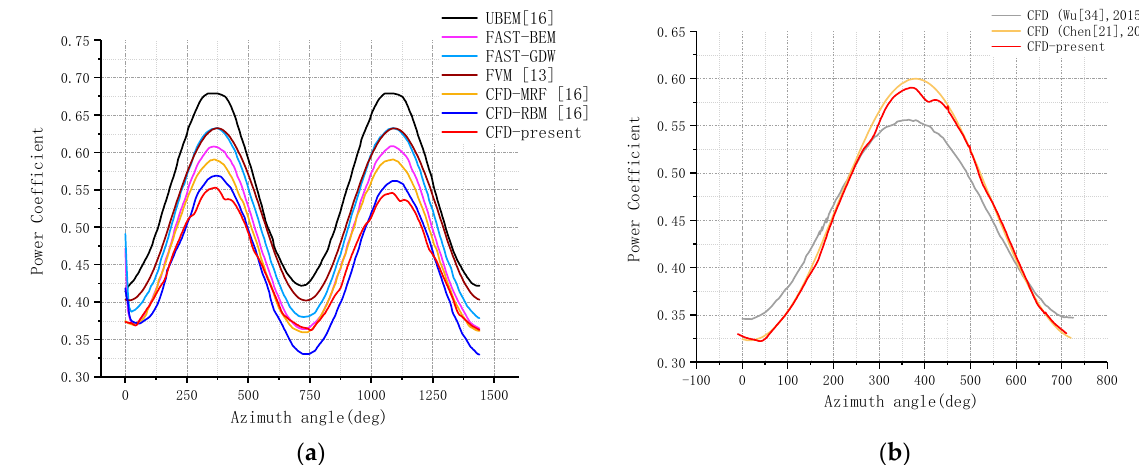
Figure 3. Power coefficient comparison results. ( a ) Pitch motion with amplitude of 1° and frequency of 0.1 Hz; ( b ) surge motion with an amplitude of 2 m and a frequency of 0.1 Hz.